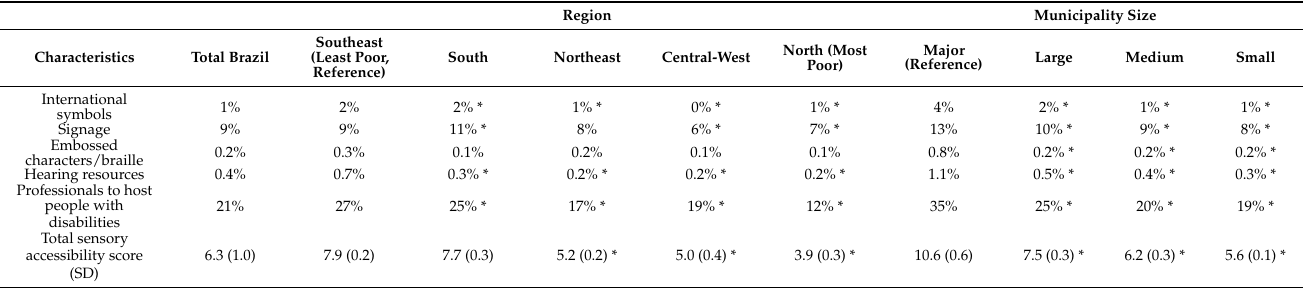
Table 5. Accessibility features of primary health care facilities for people with visual or hearing impairments, by Region of Brazil and Municipality Size.